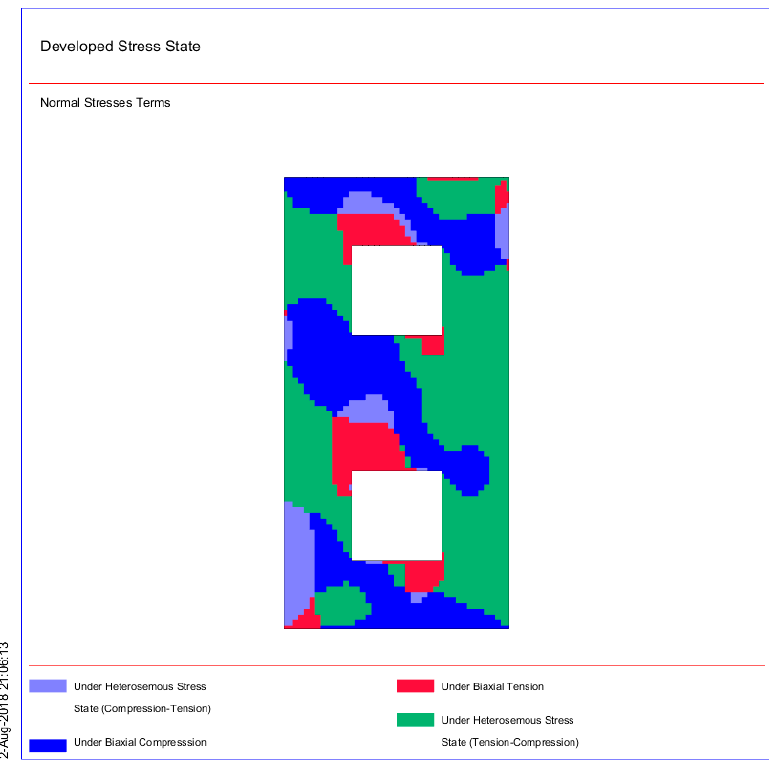
Figure 24. Developed stress state in normal stresses terms (PGA = 0.40 g).